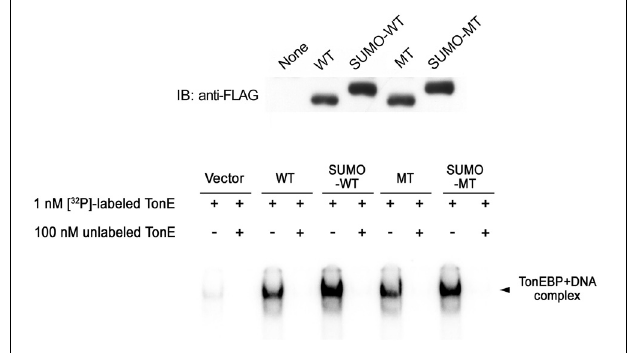
FIGURE 7 | Effects of sumoylation on DNA binding of TonEBP. Top: HEK293 cells were transfected with the constructs shown in Figure 4A . Cell lysates were prepared and immunoblotted for FLAG. Bottom : EMSA was performed on the cell lysates using 1nM [ 32 P]-labeled DNA containing TonE in the absence or presence of 100nM unlabeled DNA containing TonE as indicated (Bottom). DNA bound TonEBP is indicated.